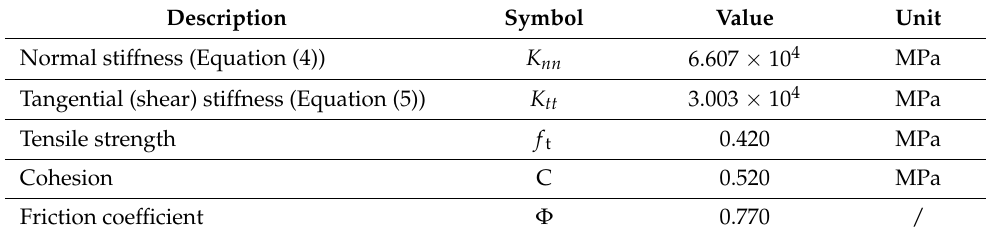
Table 5. Initial interface material